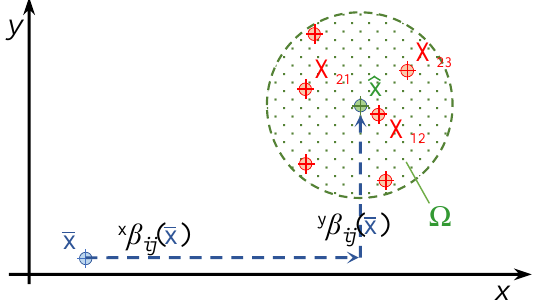
Figure 7. Expected position from the debiasing filter (ˆ x ) when applied to a measured posistion (¯ x ) in 2D. The cloud of actual positions ( X ij ) is constrained by the boundary Ω